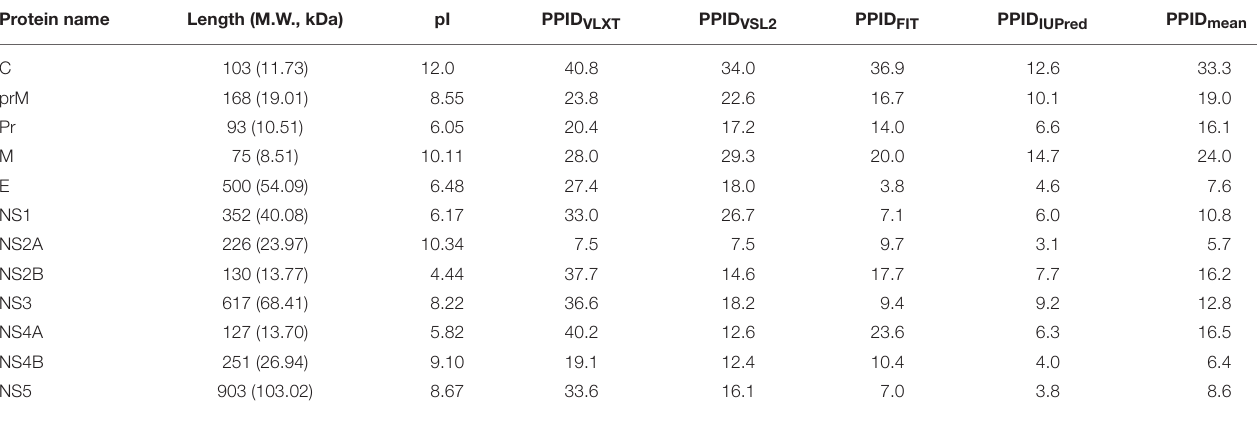
TABLE 1 | Some physicochemical and intrinsic disorder properties of Zika virus